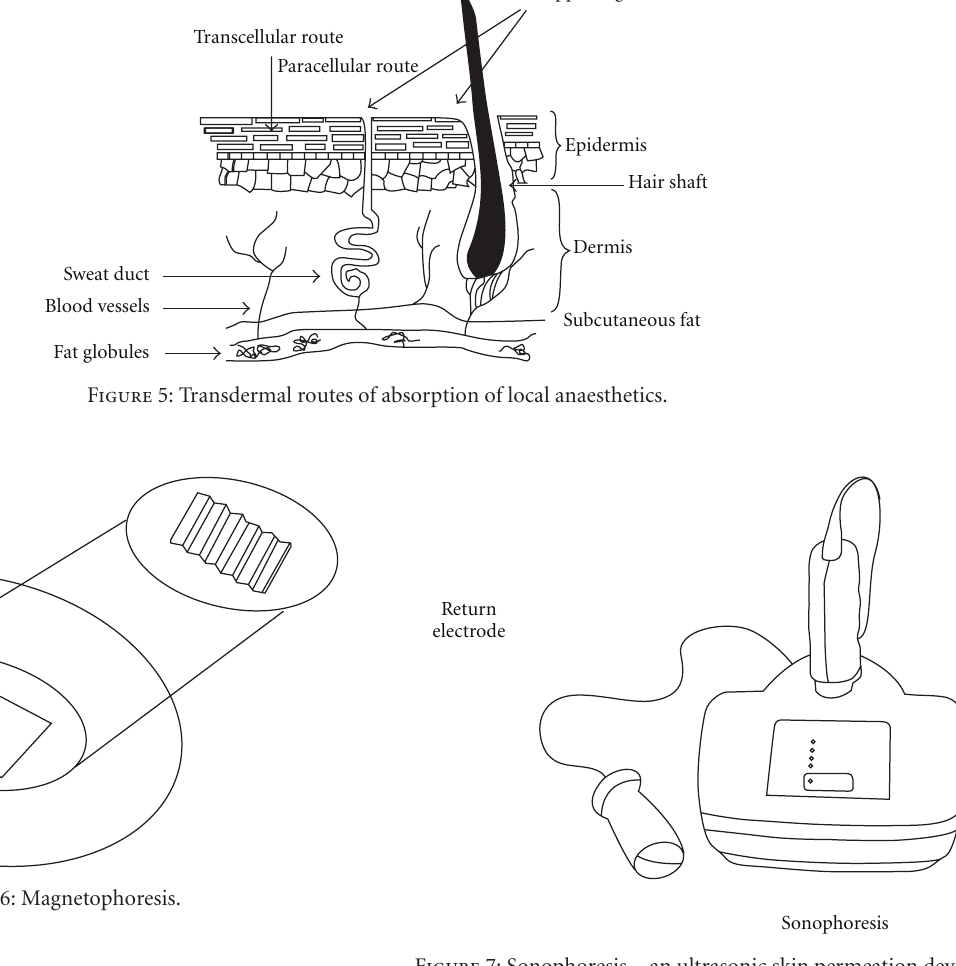
Figure 7: Sonophoresis—an ultrasonic skin permeation